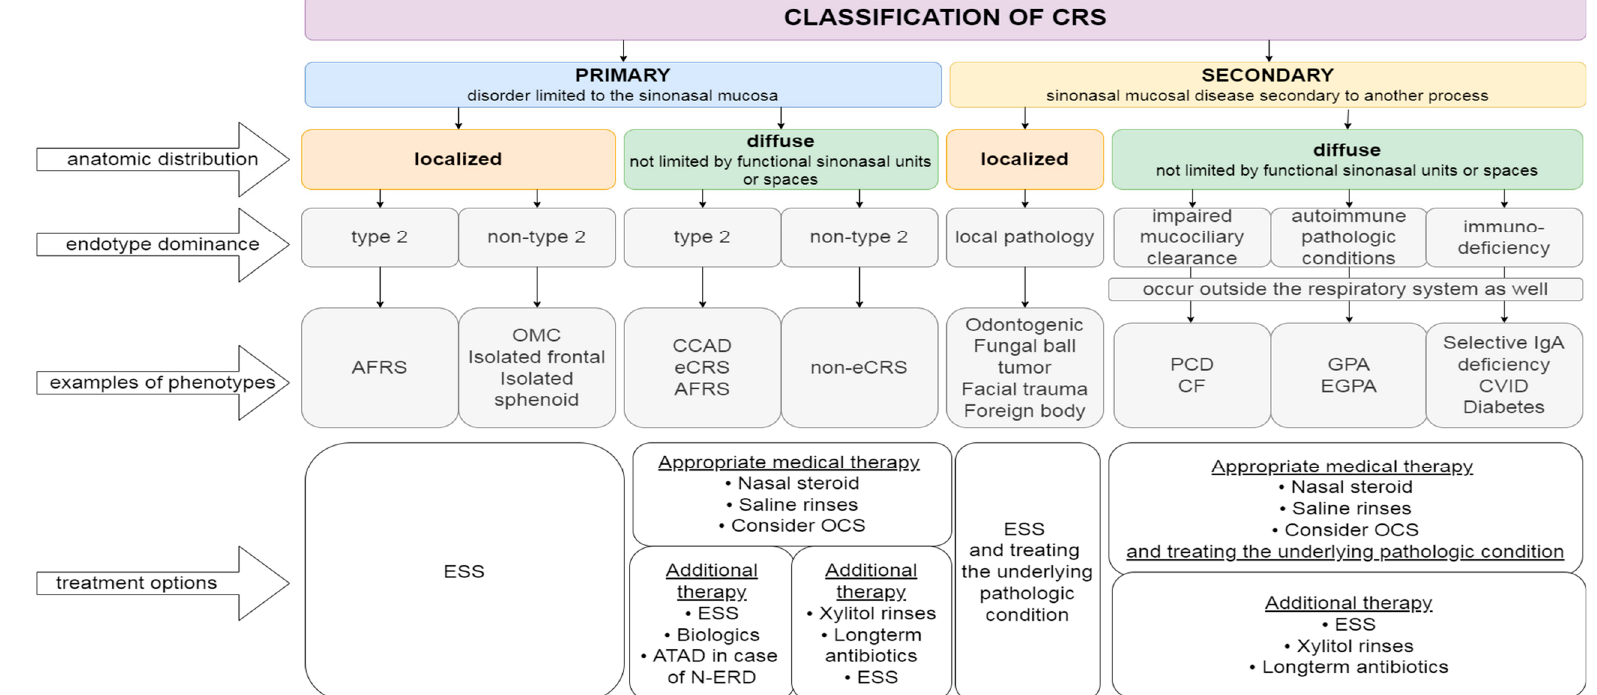
Figure 1. Classification of CRS created by Grayson et al. with general information about appropriate treatment for particular endotypes ([2,18], modified). AFRS, allergic fungal rhinosinusitis; OMC, ostiomeatal complex; CCAD, central compartment atopic disease; eCRS, eosinophilic CRS; PCD, primary ciliary dyskinesia; CF, cystic fibrosis; GPA, granulomatosis with polyangiitis; EGPA, eosinophilic granulomatosis with polyangiitis; CVID, common variable immunodeficiency; OCS, oral corticosteroid; ESS, endoscopic sinus surgery; ATAD, aspirin treatment after desensitization; N-ERD, non-steroidal anti-inflammatory drugs-exacerbated respiratory disease.